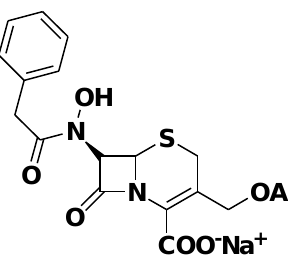
Figure 5. Chemical structure of 3-acetoxymethyl-7-(hydroxy-phenylacetyl-amino)-8-oxo-5-thia-1-aza- bicyclo [4.2.0] oct-2-ene-2-carboxylate, sodium salt. The chemical structure was drawn using the ChemDraw Ultra 7.0 software (Chem Office